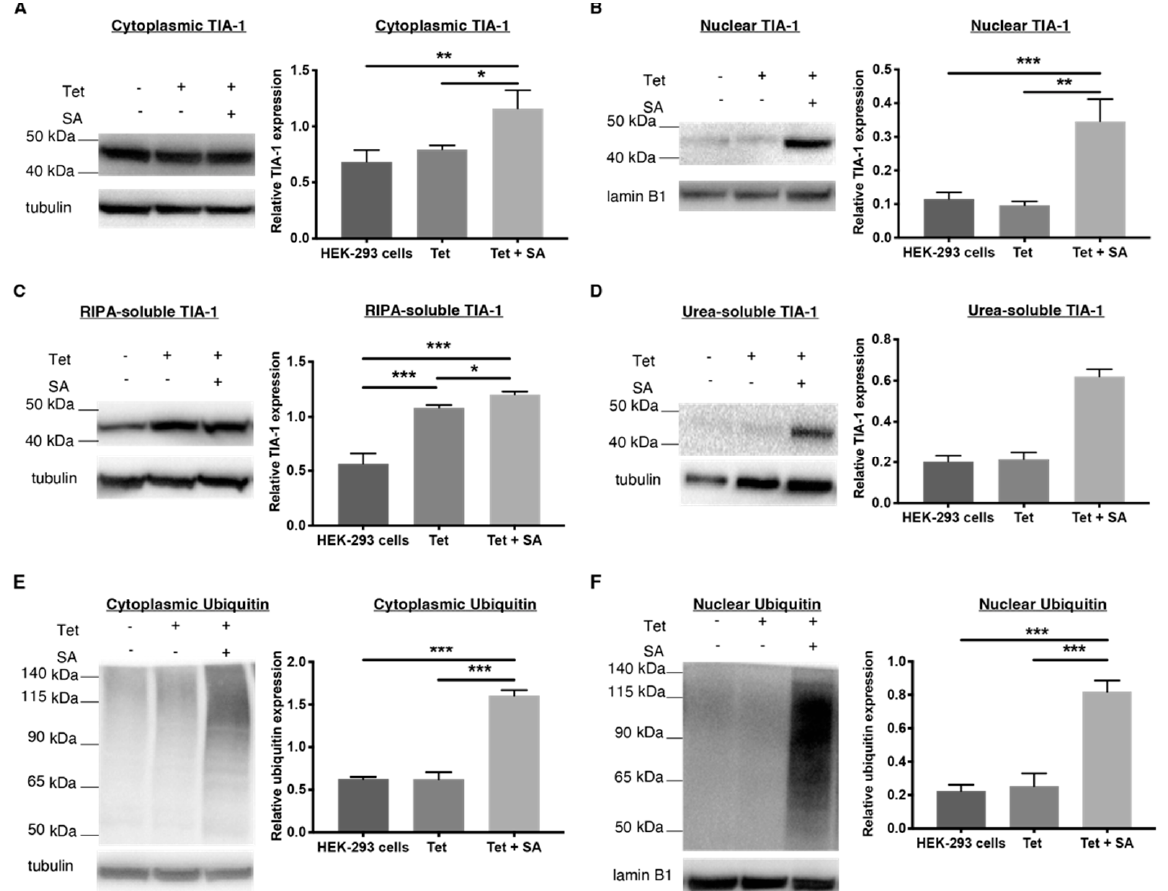
Figure 2. Comparing TIA-1 and ubiquitin expression levels in stably transfected HEK-293 cells. The expression level of the stress granule marker, TIA-1 in stably transfected HEK-293 cells with and without tetracycline (Tet, 2 µg/mL, 48 h) and sodium arsenite (SA, 15 µM, 18 h) was measured using Western blots. ( A , B ) The quantified, relative expression levels of TIA-1 in the cytoplasm and nucleus. ( C , D ) RIPA- and urea-soluble TIA-1 expression. The Western blots and corresponding histograms showing ubiquitin expression levels in the ( E , F ) cytoplasm and nucleus of HEK-293 cells. TIA-1 and ubiquitin are normalised to α -tubulin for the cytoplasmic, RIPA-soluble and urea-soluble fraction and lamin B1 for the nuclear fraction. Data represent mean ± SD, n ≥ 3, and significant differences between means were examined with a one-way ANOVA with Tukey’s multiple comparison test. * p < 0.05, ** p < 0.01, *** p < 0.001.